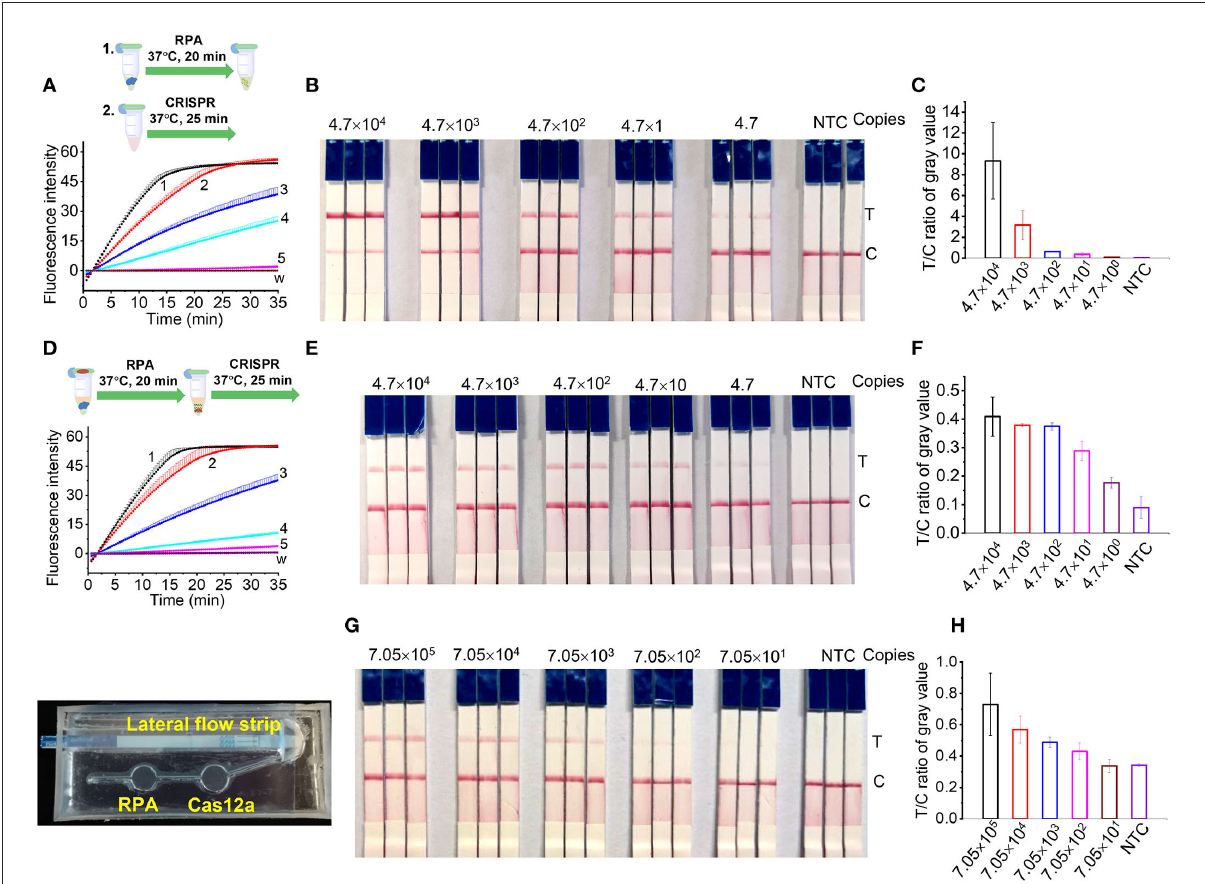
FIGURE5 Sensitivity of RPA/CRISPR/Cas12a detection. (A,B) Two-step detection of L. maculans genomic DNA using fluorescence probe (A) and lateral flow strips (B) . (C) The ratio of gray value between T line and C line of lateral flow strips in (B) . (D,E) One-pot detection of L. maculans genomic DNA using fluorescence probe (D) and lateral flow strips (E) . (F) The ratio of gray value between T line and C line of lateral flow strips in (E) . Lines 1-5 indicated the genomic DNA copies. 1, 4.7 × 10 4 ; 2, 4.7 × 10 3 ; 3, 4.7 × 10 2 ; 4, 4.7 × 10 1 ; 5, 4.7. (G) Detection of AOCLFP. (H) The ratio of gray value between T line and C line of lateral flow strips in (G)